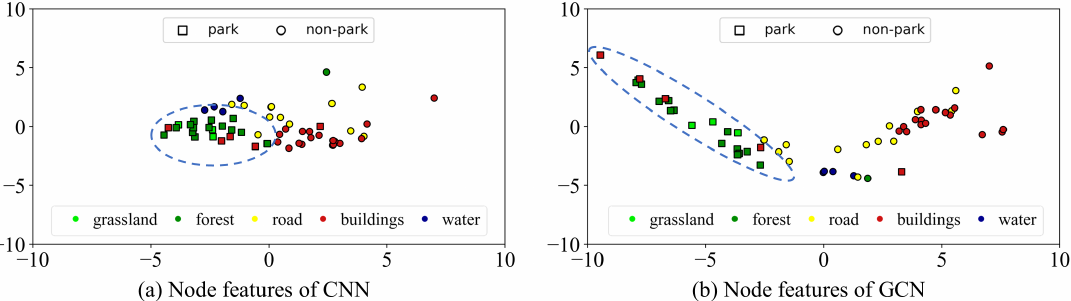
Figure 9. Node feature distributions of the CNN module and the GCN module, where PCA reduces the feature dimension to two. The park cluster is highlighted with a blue dashed circle and nodes are rendered by their land cover